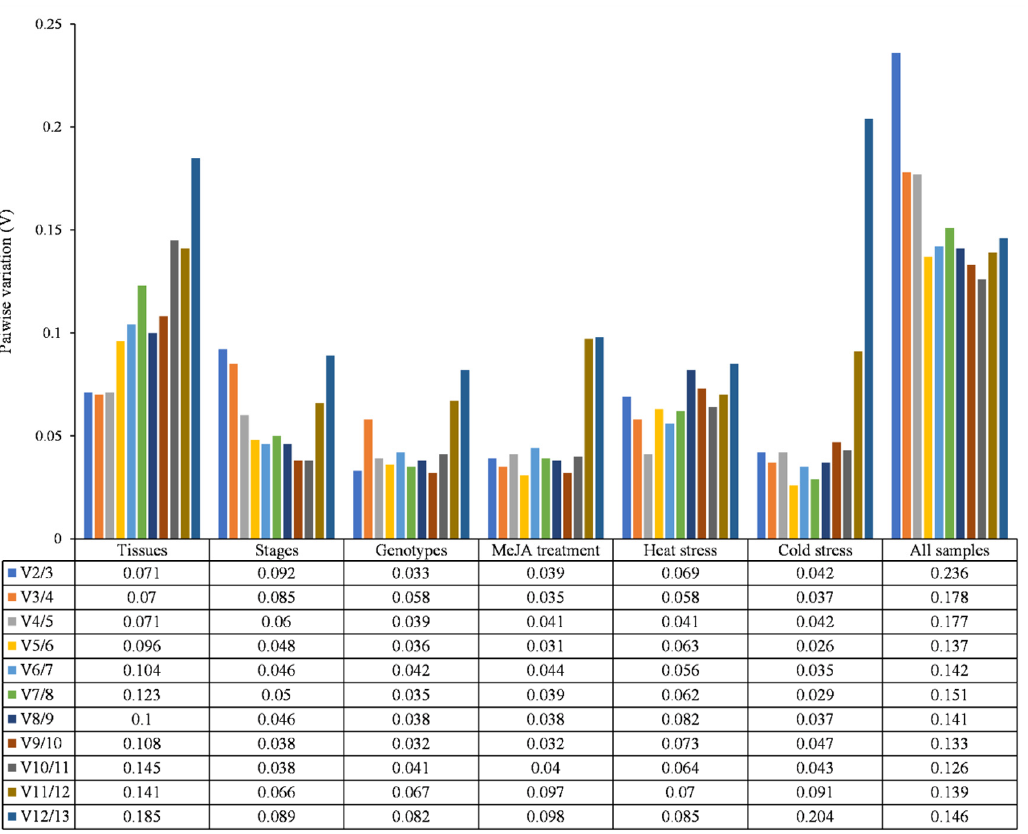
Figure 3. Pairwise variation (V) of thirteen candidate reference genes according to geNorm. The Vn/n + 1 is used to determine the optimal number of reference genes for accurate normalization. A cut-off value of Vn/n + 1 < 0.15 indicates that no additional reference genes need to be added. Otherwise, n + 1 genes need to be introduced.